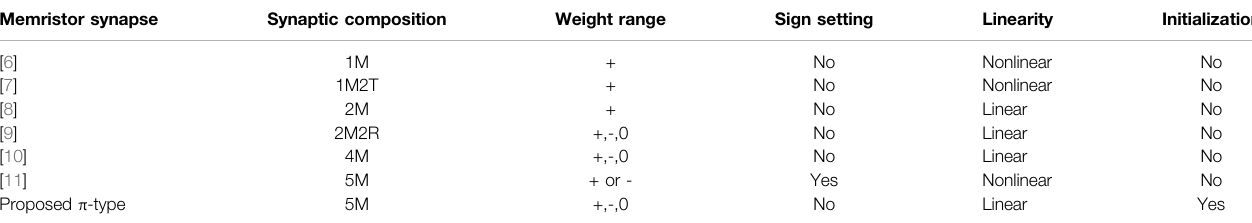
TABLE 2 | Comparison of the characteristics of several common memristor synapses. Memristor synapse Synaptic